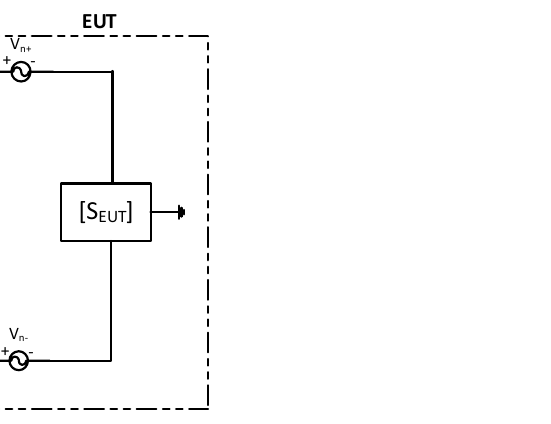
Figure 5. Equivalent circuit of the EUT connected to the equivalent circuit of a LISN according to CISPR 16.